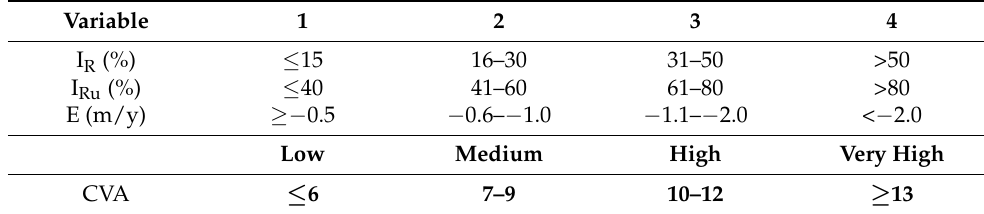
Table 3. Coastal vulnerability assessment (CVA) classification scheme (according to